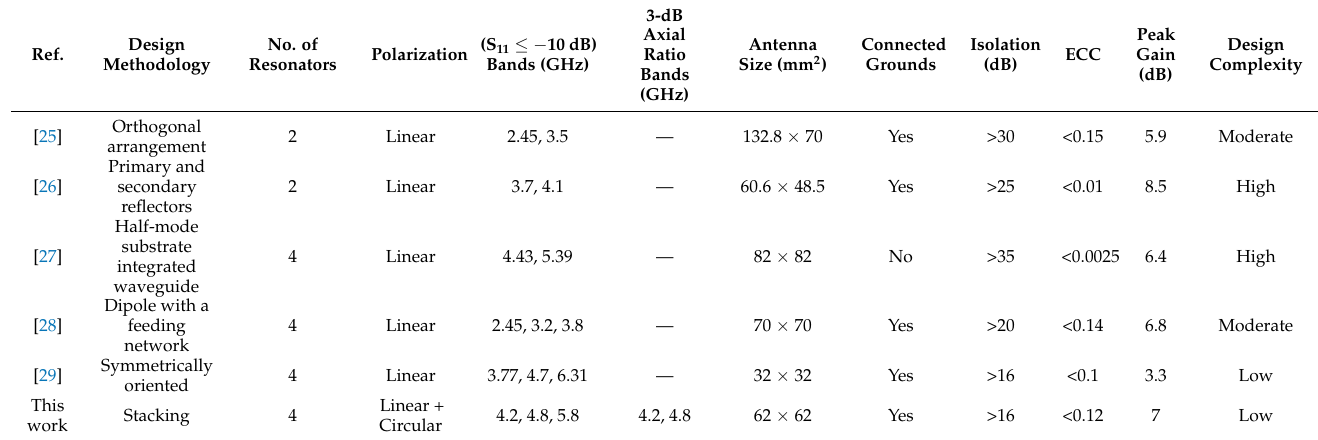
Table 3. Performance comparison with the reported multiband MIMO